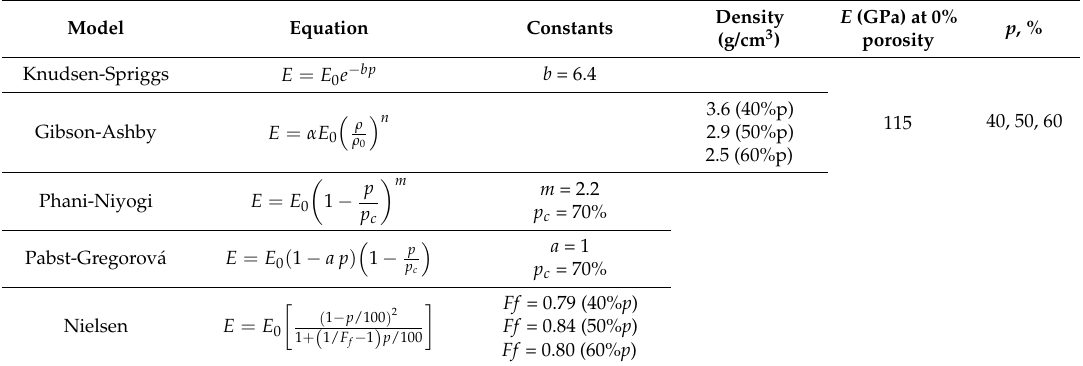
Table 1. Values of the constants used in different models reported in the literature to estimate the value of E .